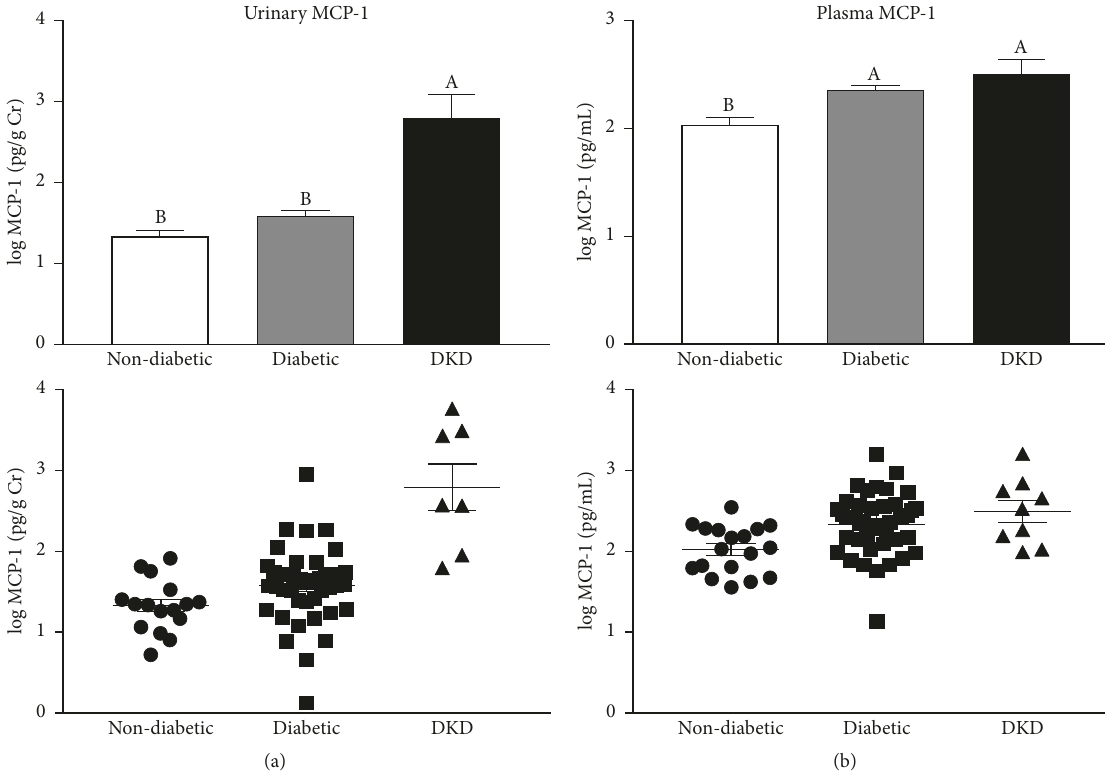
Figure 8: Plasma and urinary monocyte chemoattractant protein-1 (MCP-1). Log-transformed plasma (a) and urinary (b) MCP-1 levels among nondiabetic subjects, diabetic patients with no known kidney disease (diabetic), and patients with diagnosed diabetic kidney disease (DKD). Urinary MCP-1 levels were normalized to creatinine to account for differences in urine concentration. Data are represented as both a bar chart showing mean log MCP-1 ± SEM within each group (top) and a scatter plot showing values for each individual within the group (bottom). Labeled means without a common letter are significantly different from one another (𝑝 < 0.05) based on one-way ANOVA and Tukey’s honest significant difference